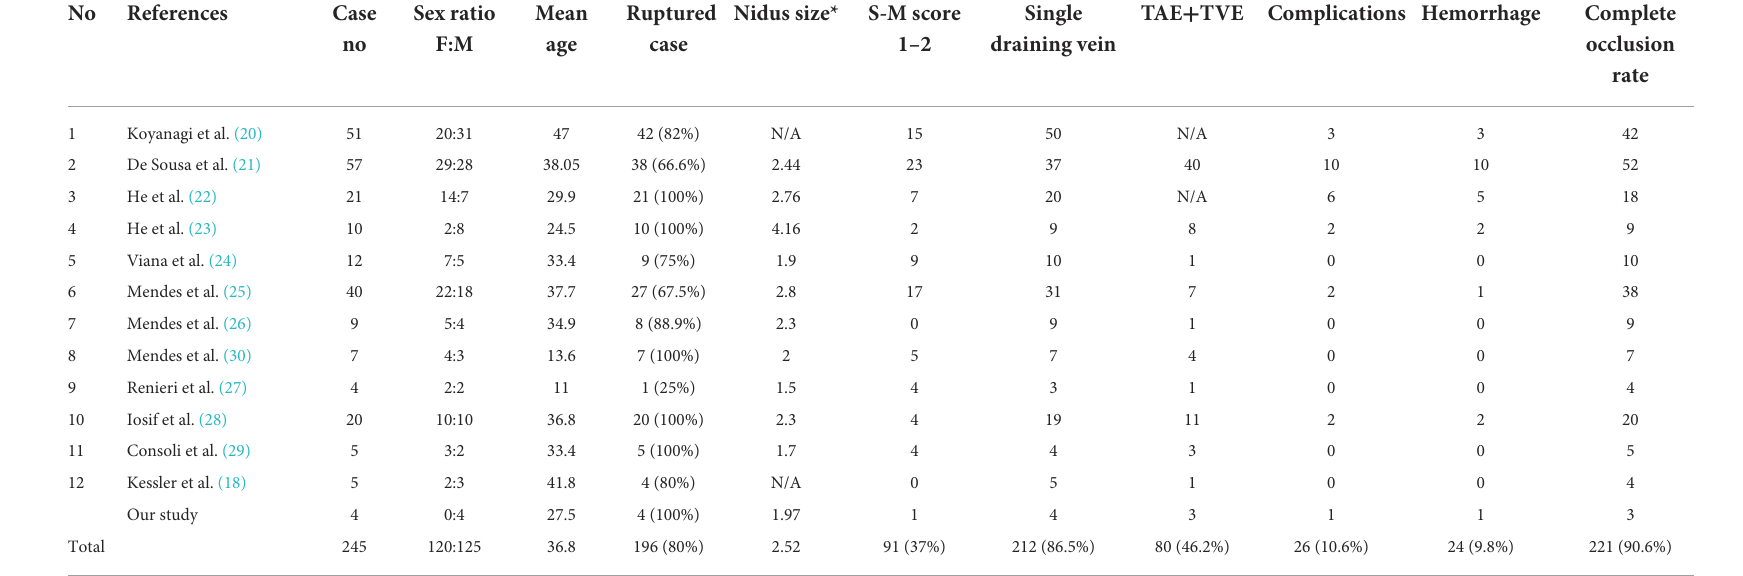
TABLE 2 Literatures review of endovascular treatment of AVMs via transvenous